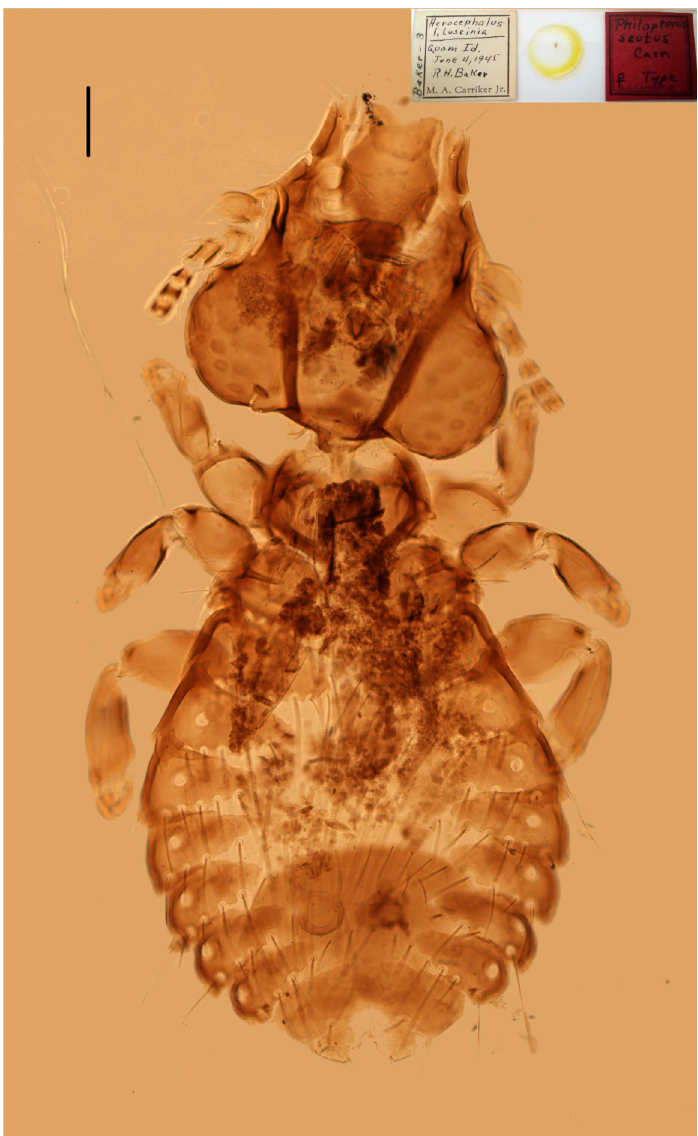
Fig. 1. Philopterus acrocephalus Carriker, 1949 ex Acrocephalus luscinius : female holotype (USNM No. 58960), dorsal view. Scale bar: 0.1